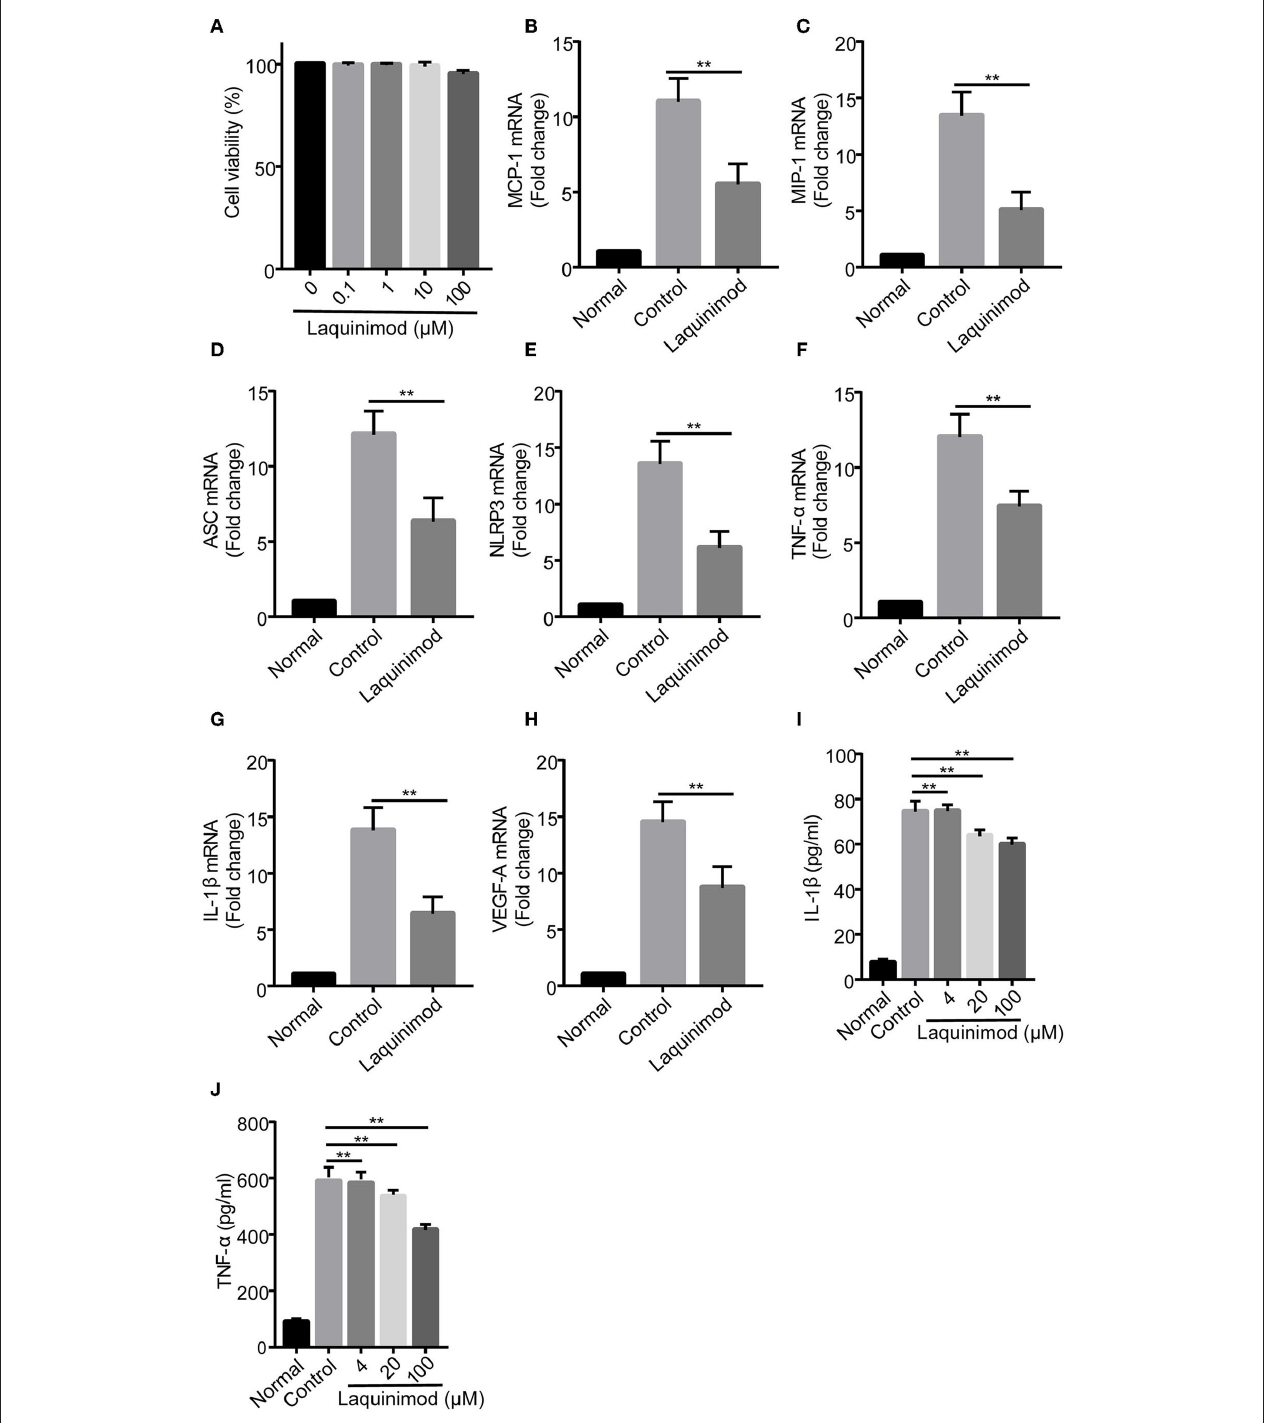
FIGURE 4 | Chemotactic factor, inflammasome, and pro-inflammatory factor expression in laquinimod-treated RAW cells. (A) RAW cells were seeded in a 6-well plate at a density of 1 × 10 6 cells/well in growth medium and treated with laquinimod (0, 0.1, 1, 10, and 100 µ M) in the presence of LPS for 24h. After treatment, the cytotoxic activity of laquinimod was evaluated by trypan blue dye exclusion assay. (B–H) RAW cells were seeded in a 6-well plate at a density of 5 × 10 5 cells/well in growth medium and treated with laquinimod (0, 4, 20, and 100 µ M) in the presence of LPS (100ng/mL) for 8h. The cell lysates and RNA were collected. The mRNA levels of chemokines (MCP-1 and MIP-1), pro-inflammatory cytokines (IL-1 β and TNF- α ), VEGF-A, NLRP3, and ASC were detected by RT-PCR and normalized to GAPDH. (I,J) RAW264.7 cells were cultured with or without laquinimod (4, 20, and 100 µ M) and 100ng/mL LPS for 24h. The secretion of IL-1 β and TNF- α in RAW 264.7 were examined by ELISA after the treatment of laquinimod. The results are expressed as the mean ± S.E.M. PBS as control, ** p < 0.01, laquinimod vs. control.